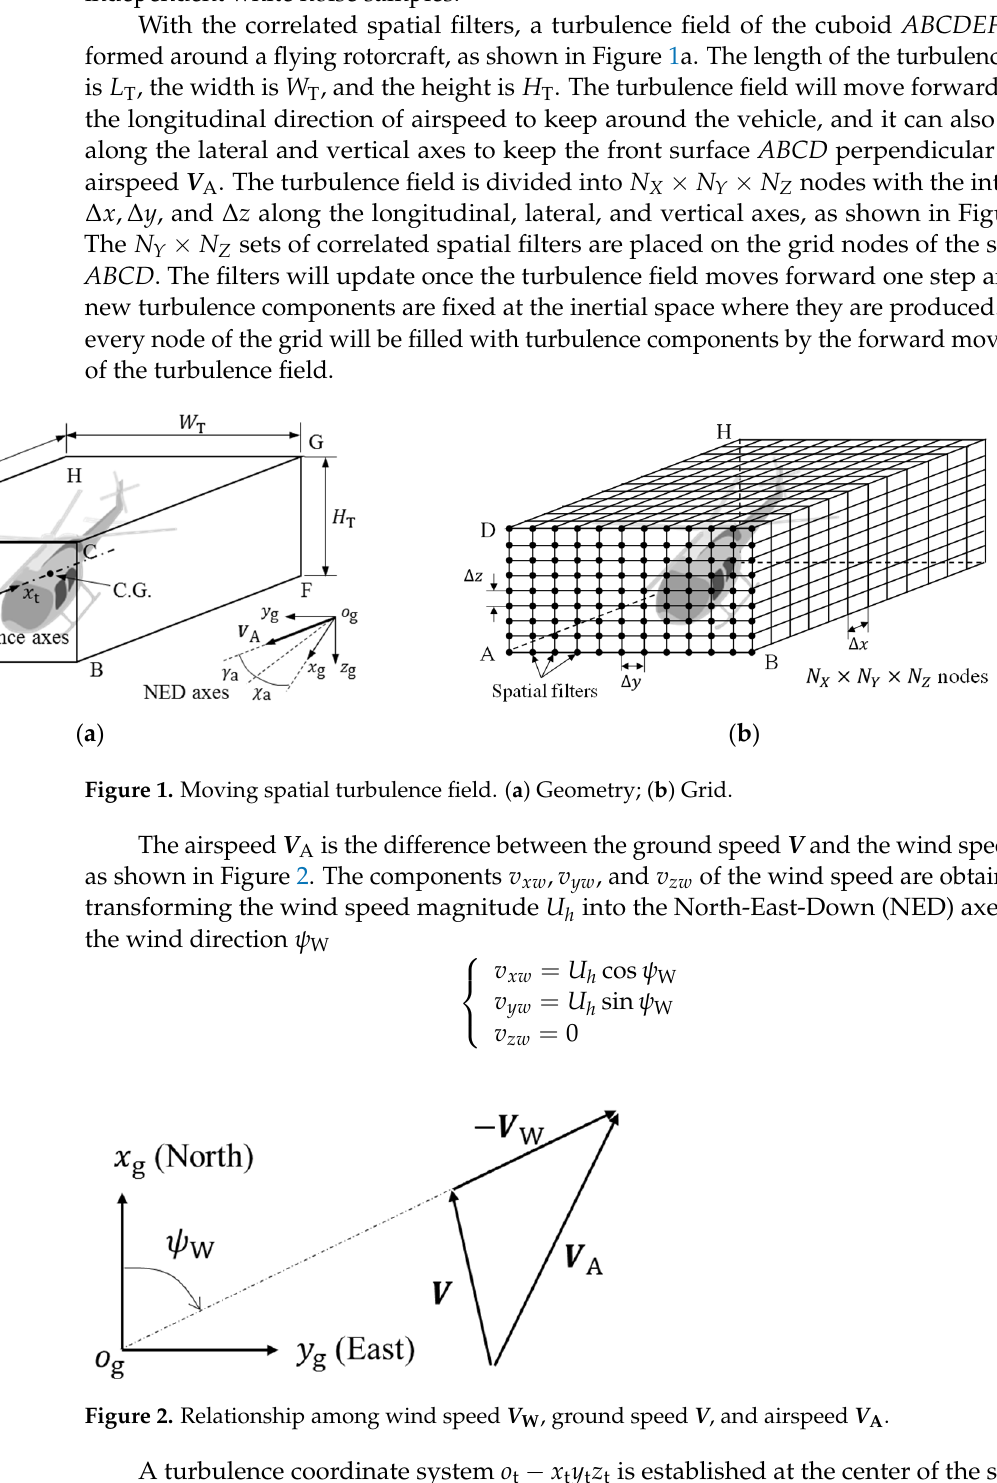
. Figure 2. Relationship among wind speed V W , ground speed V , and airspeed V A 𝐀